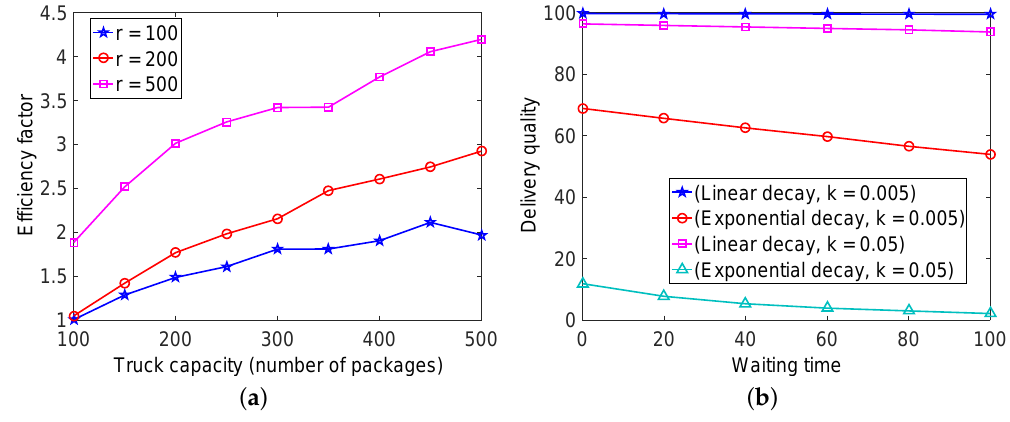
Figure 9. ( a ) Variation of efficiency factor with different demand rates. ( b ) Effect of package waiting time on delivery